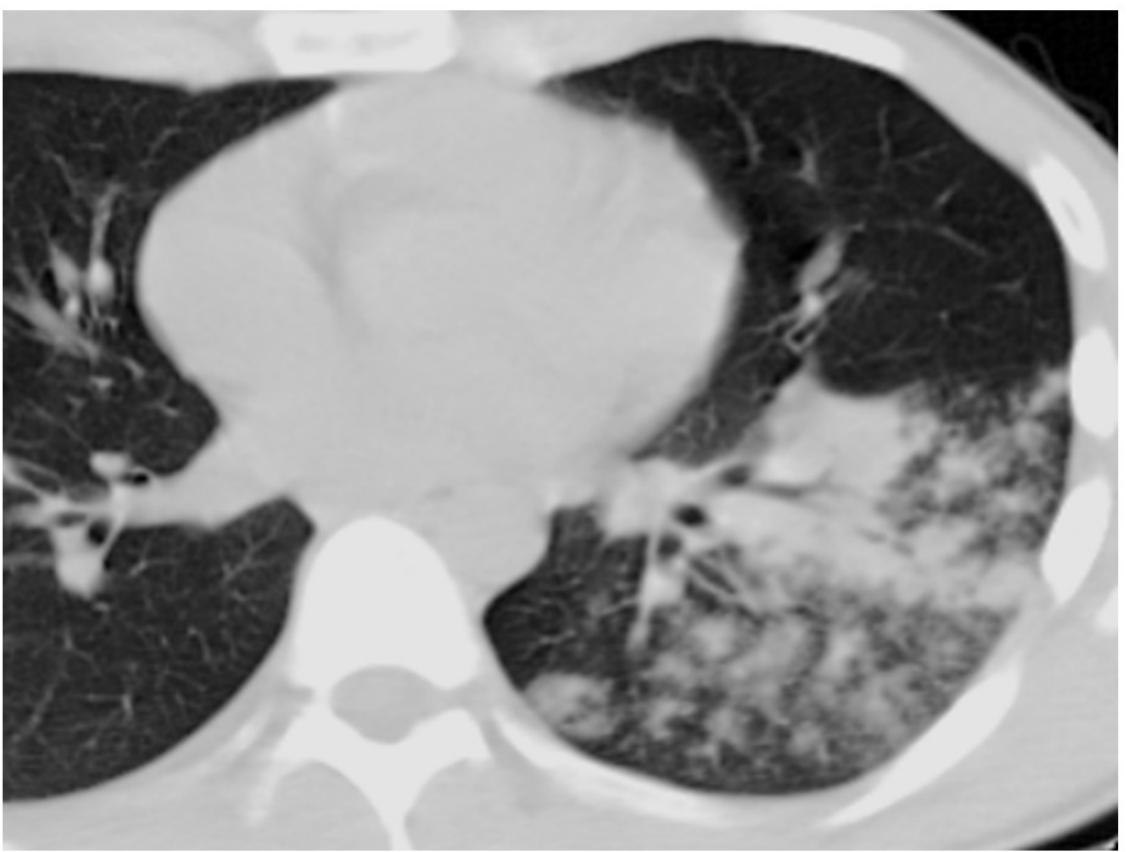
Figure 4. Axial computed tomogram. An extensive area of lung tissue consolidation in the lower lobe of the left lung with air bronchogram signs and with the presence of perifocal alveolar–interstitial ground-glass opacity.